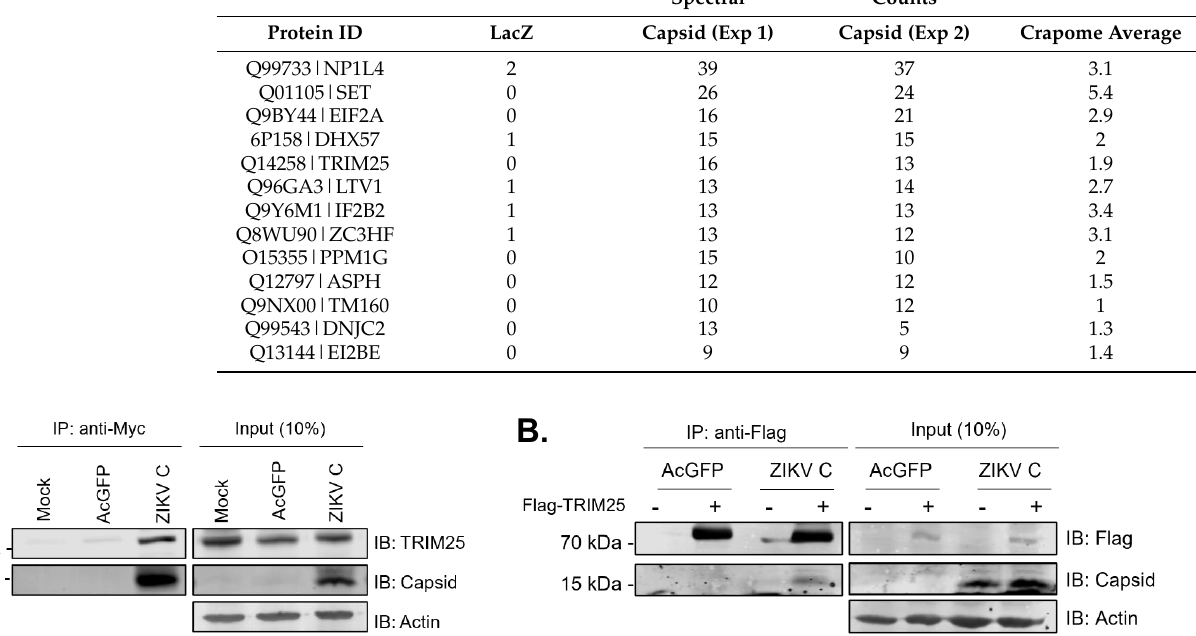
Figure 6. ZIKV capsid interacts with TRIM25. ( A ) Myc-tagged ZIKV capsid-expressing cells were lysed and co-immunoprecipitation was performed using anti-Myc beads. Immunoblots were probed for TRIM25, capsid and actin. ( B ) Flag-TRIM25-expressing cells were lysed and co-immunoprecipitation was performed using anti-Flag beads. Immunoblots were probed for Flag, capsid and actin. Each experiment in panels A and B was conducted at least three times.